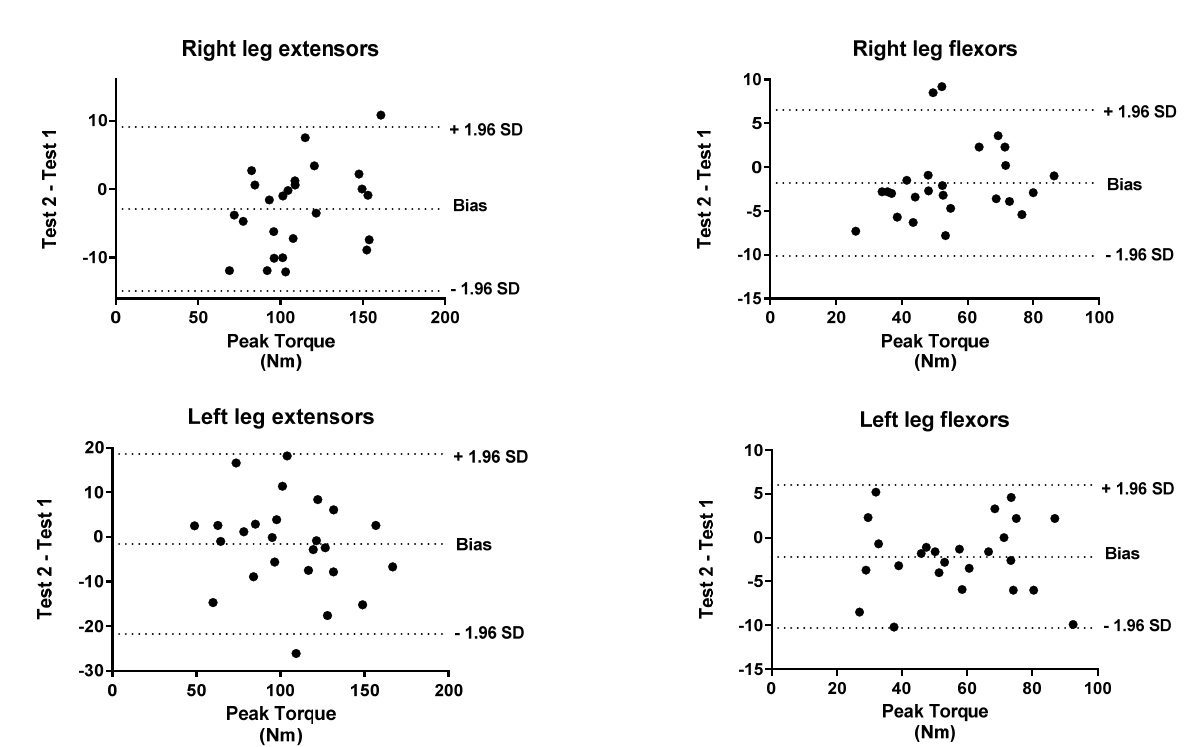
Figure 5. Men Bland–Altman peak torque analysis for Right and Left Legs in flexion and Extension.